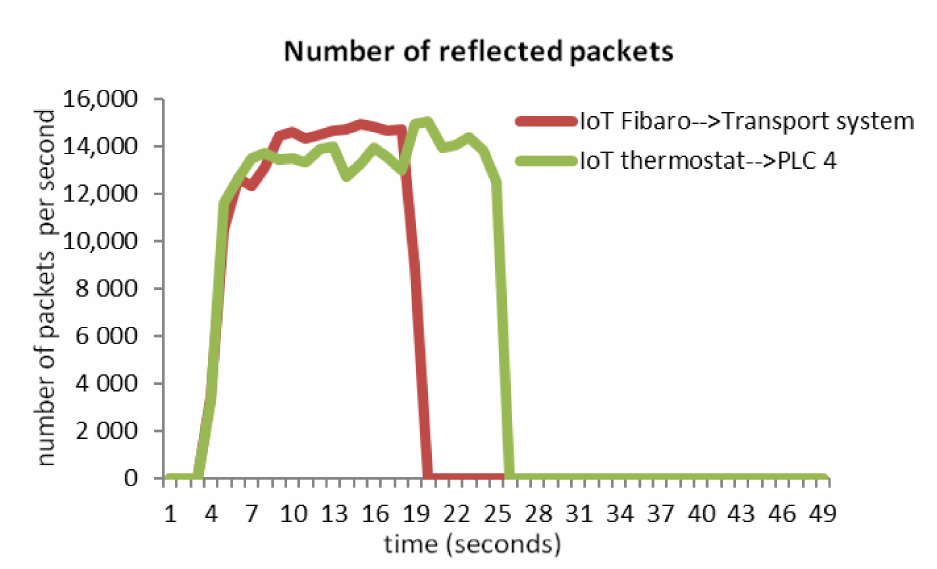
Figure 5. A visual illustration of the scenario 1